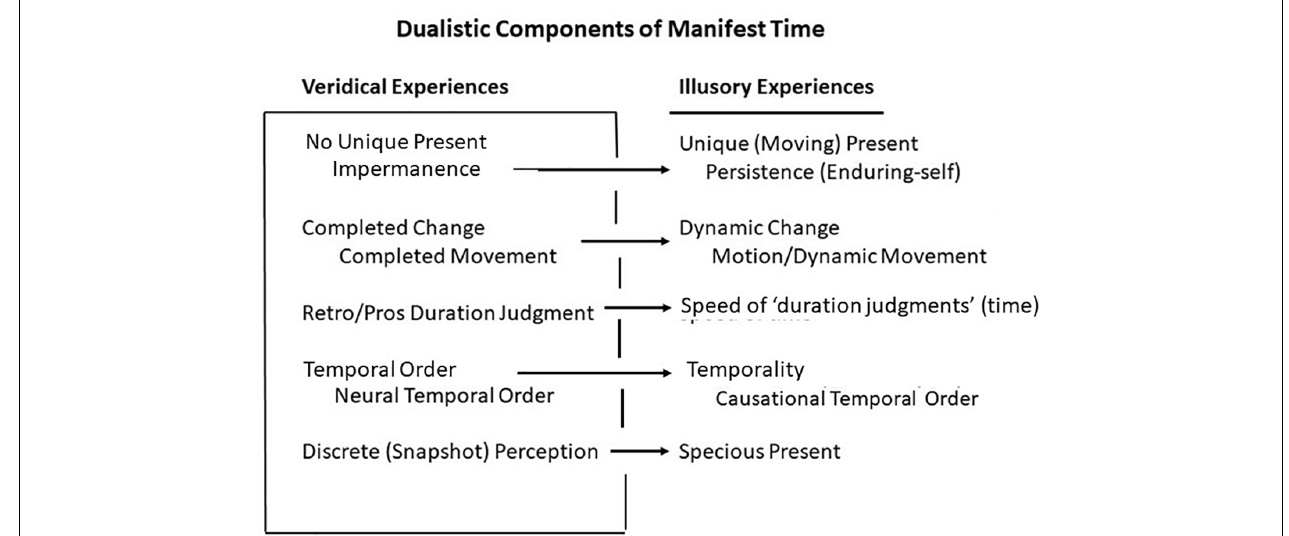
FIGURE 2 | Major components of manifest time. Veridical components beget illusory components.